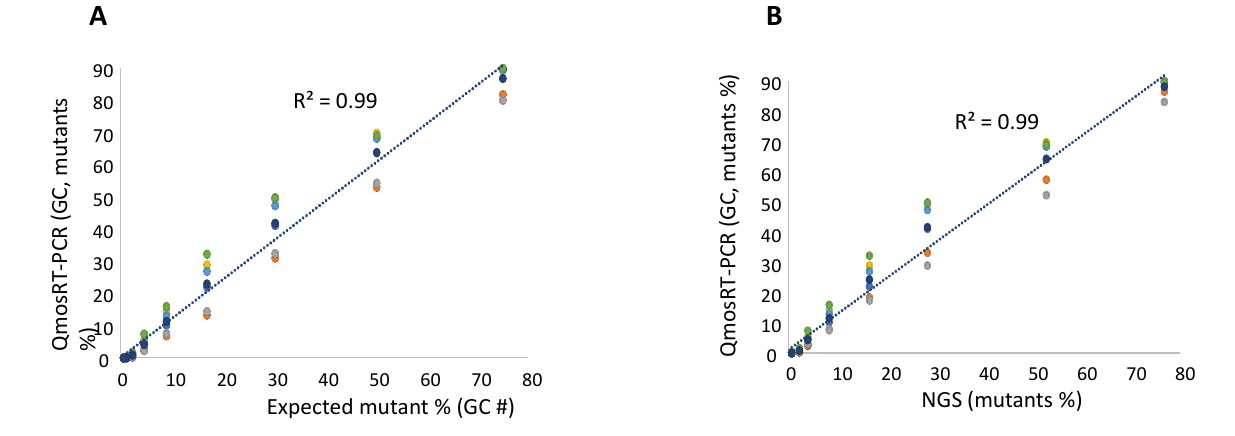
Figure 3. Results of the qmosRT-PCR assay using plasmid reference standards for quantification of nOPV2-c1_171 mutants, generated from the virus-spiked samples: ( A ) the mutant percentages generated by qmosRT-PCR are plotted against the expected percentages of mutants and ( B ) the mutant percentages generated by qmosRT-PCR are plotted against the results of Illumina sequencing (NGS). The correlation line is drawn for the averages of the qmosRT-PCR results. The results of different qmosRT-PCR run (Table 3) are presented with different colors.